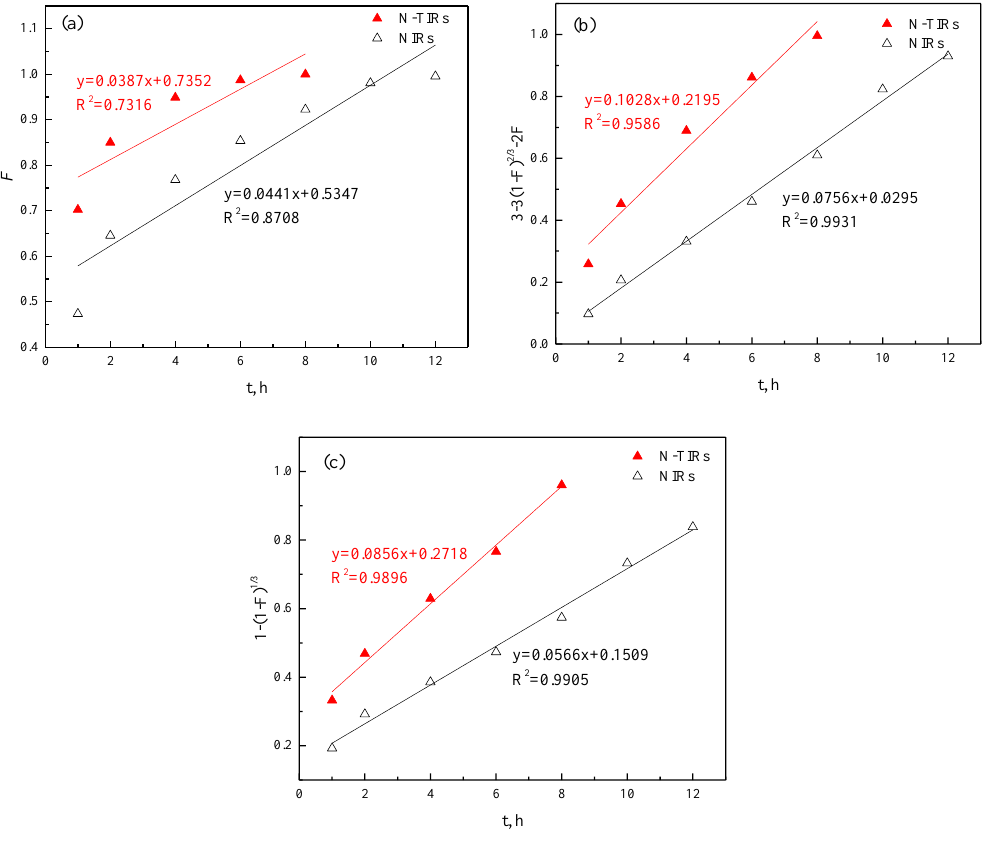
Figure 10. Fitting for the adsorption of V(V) by Shrinking core mode ( a ) fluid film diffusion, ( b ) intraparticle diffusion, and ( c ) chemical reaction. Table 4. Parameters of the shrinking core model for V(V) adsorption onto the solvent-impregnated resins (SIRs). R SIRs